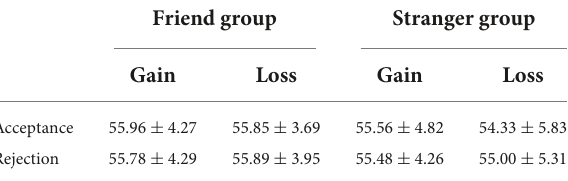
TABLE 1 The number of accepted trials in response to outcome feedbacks following the advisee’s decisions in the friend and stranger groups ( M ± SD